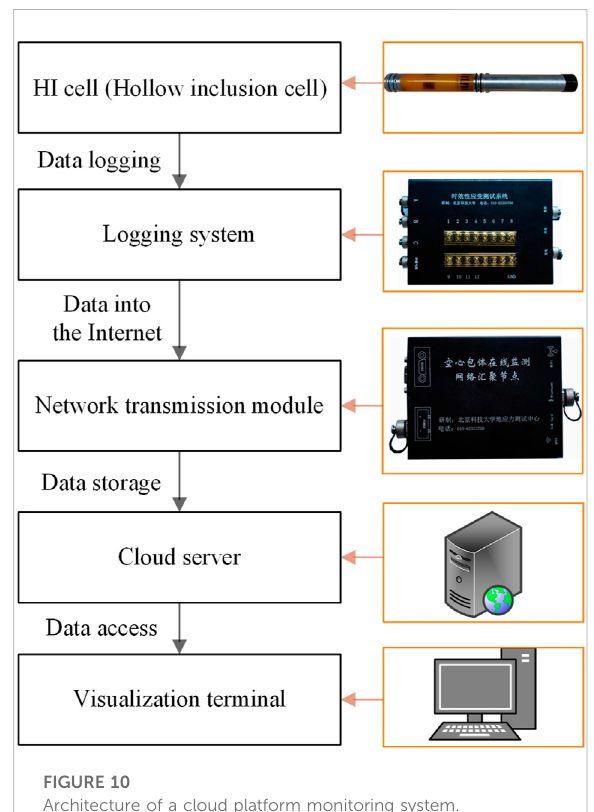
FIGURE 10 Architecture of a cloud platform monitoring